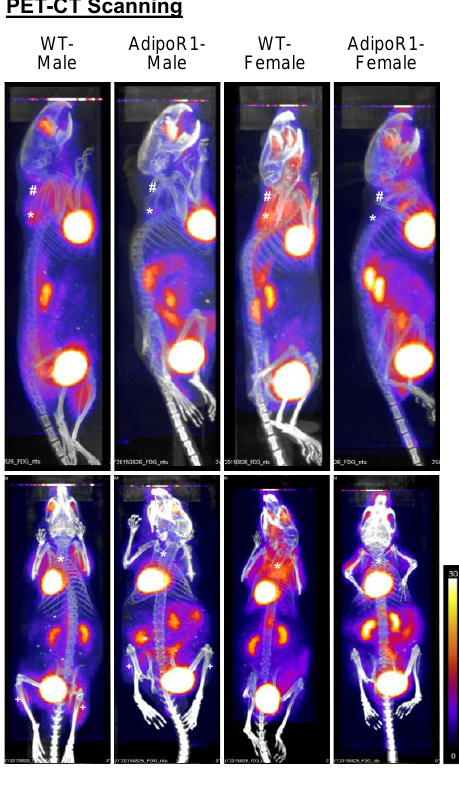
Figure 2. Inhibited cold-induced thermogenesis in vivo in classical brown and beige adipose depots of AdipoR1 mice. After two-week cold acclimation, WT and transgenic AdipoR1 mice were anesthetized and evaluated for cold-induced thermogenesis by live positron emission tomography/computed to- mography (PET/CT) scanning. Timeline and procedures were described in Figure 1. Radiotracer of 18 F-fluorodeoxyglucose ( 18 F-FDG) was injected into the tail-vein to evaluate cold-enhanced glucose uptake in vivo. Asterisks (*) indicate classical iBAT and hashmarks (#) and plus signs (+) indicate supWAT and iWAT (potential depots for WAT browning or beiging), respectively. Procedures in different groups of mice were repeated at least twice. 3D-constructed videos are displayed in the Supplementary